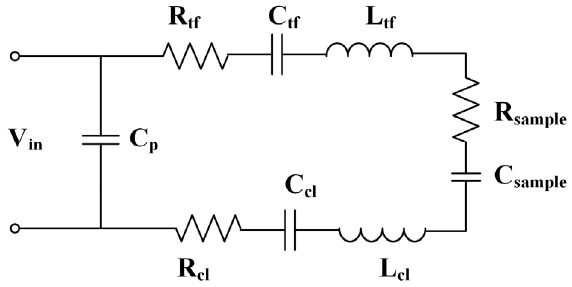
Figure 11. The equivalent electrical model of the Akiyama probe.